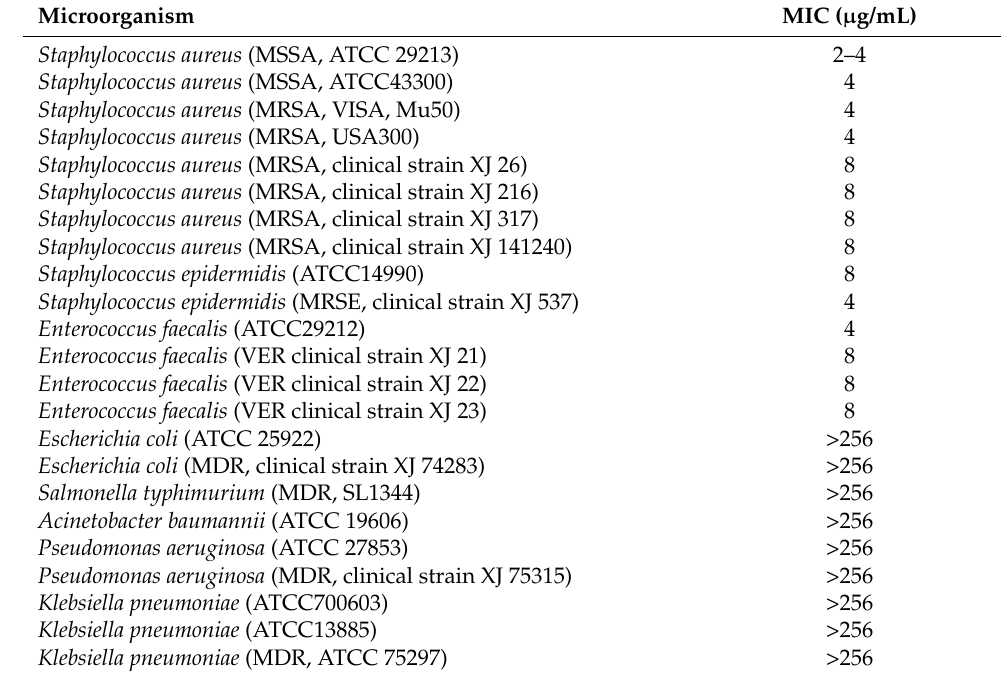
Table 1. Activity of SA2 against pathogenic bacteria.